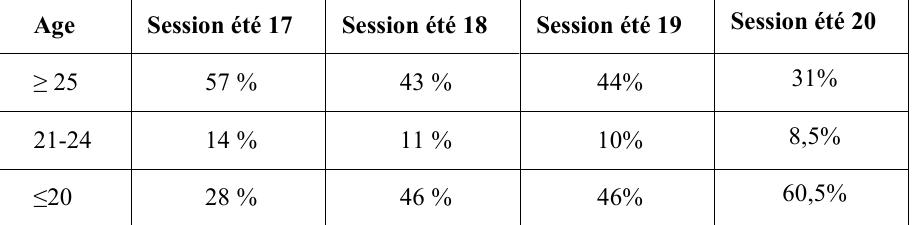
Tableau 1. Nombres d’inscrits pour les session d’été et la session d’automne.